Question: Express in one sentence what the figure is showing.
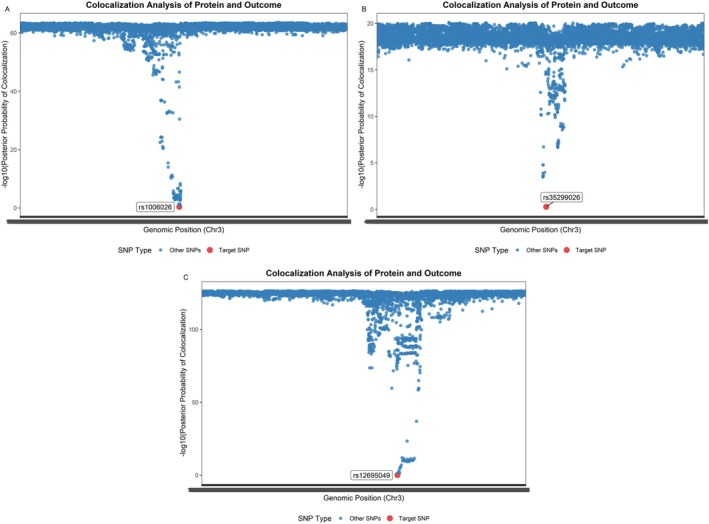
Answer: Visualization of 3 plasma proteins co‐localization results. A: Regional association plot of CD30 ligand protein (TNFSF8) with OC risk. Dominant SNPs are shown as red dot. SNPs within ±1 MB of the protein quantitative trait locus are included. (B) Regional association plot of DHB14 protein (HSD17B14) with OC risk. Dominant SNPs are shown as red dot. SNPs within ±1 MB of the protein quantitative trait locus were included. (C) Regional association plot of XXLT1 protein (XXYLT1) with oral cancer risk. Dominant SNPs are shown as red dot. SNPs within ±1 MB of the protein quantitative trait locus were included.